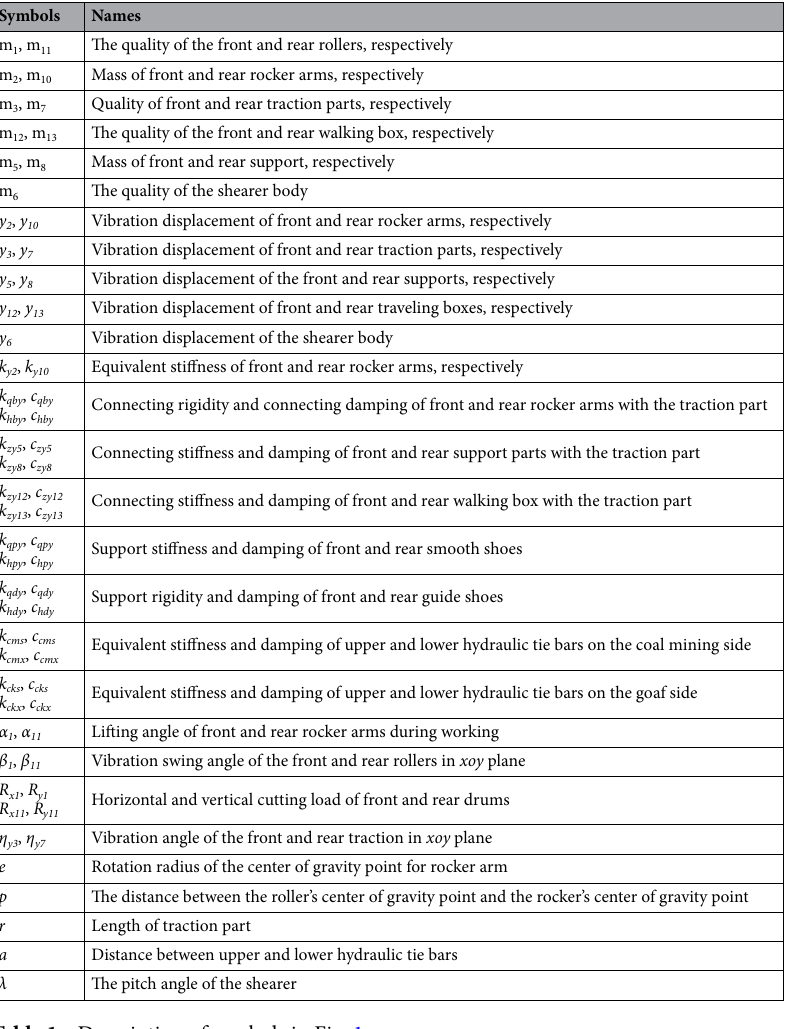
Table 1. Description of symbols in Fig.